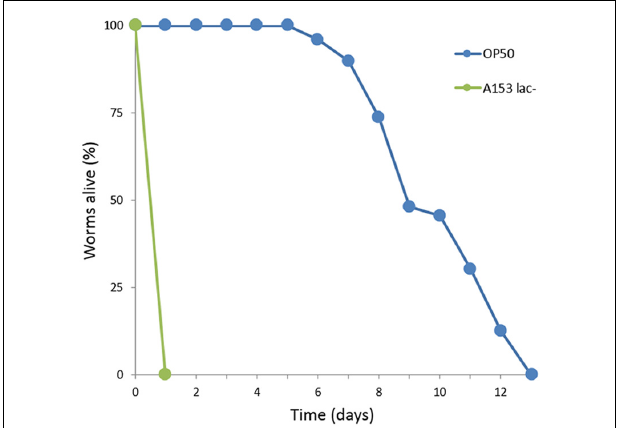
FIGURE 1 | Serratia plymuthicaA153 antagonizes Caenorhabditis elegans. Survival of C. elegans when cultured on S. plymuthica A153.The results of a representative trial with at least 50 worms under each condition is shown.